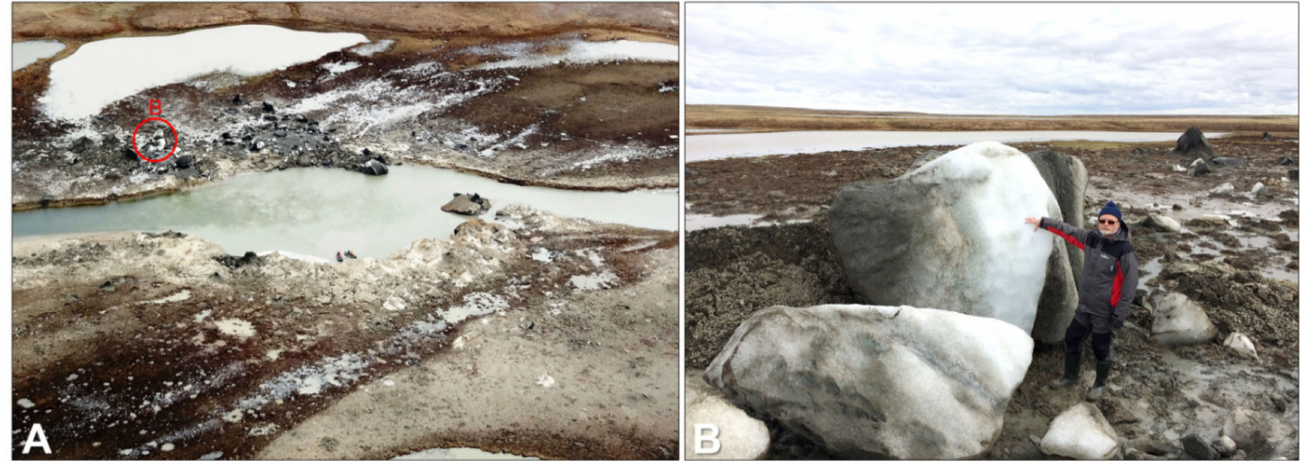
Figure 3. Seyakha Crater C11 of gas blowout ( A ) and massive fragments of ground ice ejected by the explosion ( B ) 2 July 2017 (photos by Vasily